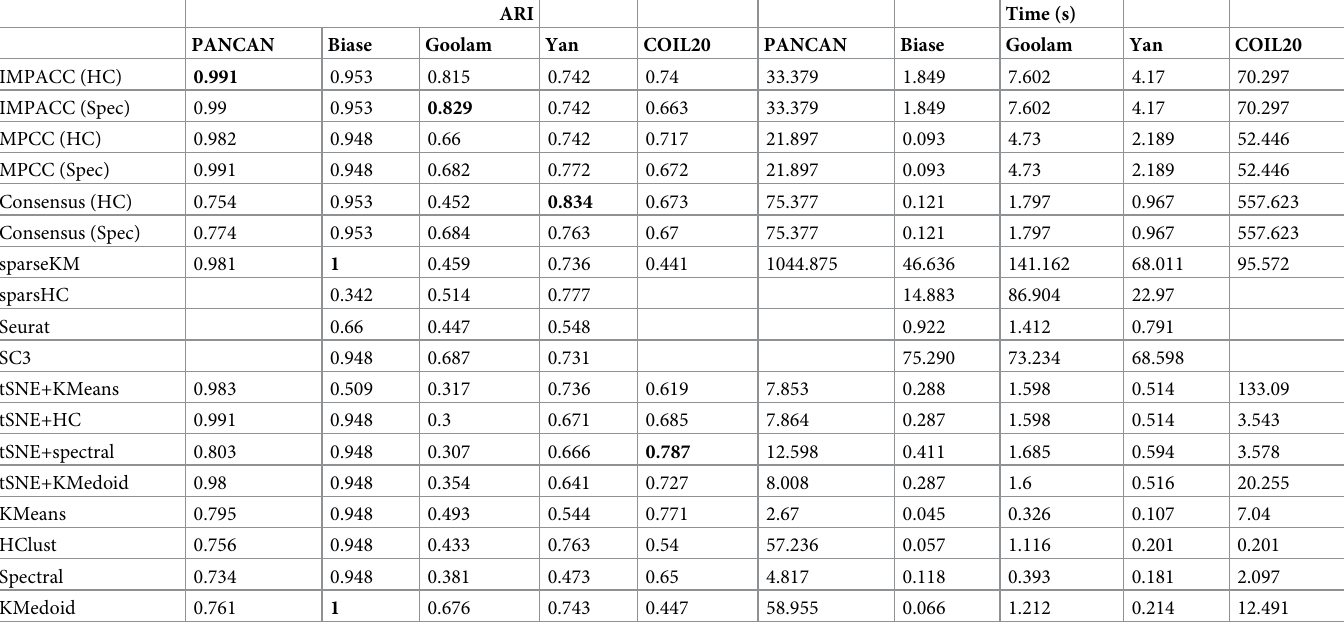
Table 2. Clustering performance (ARI) and computation time in seconds on real data sets with known cluster labels. ARI Time